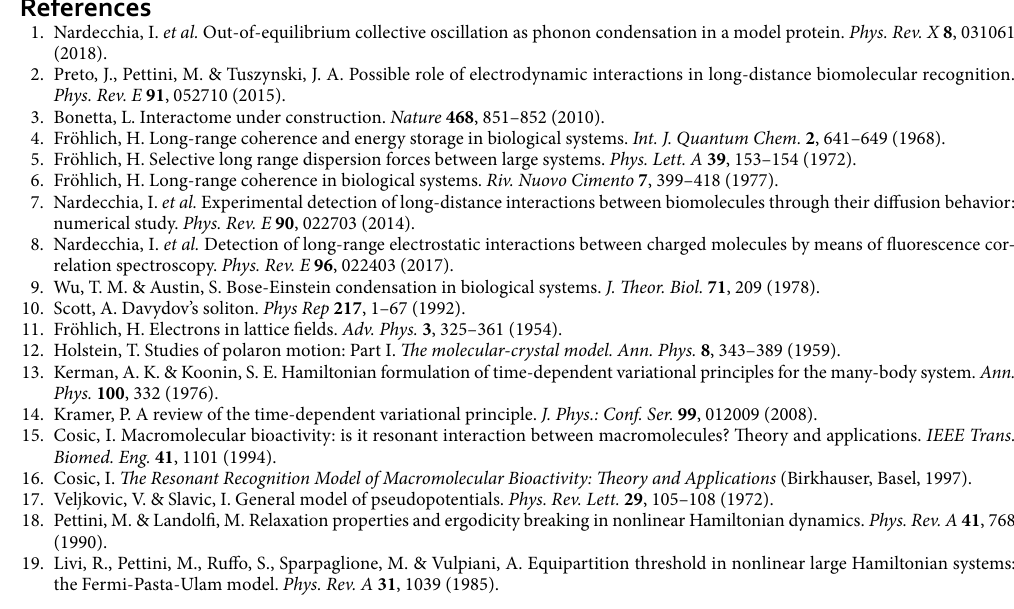
0.5 ( χ 61 = = 0.5 (light green). Upper right panel: ′ = 0.3 (red), µ 0.5 (light green). Lower ′ = ′ = 1. (blue), ǫ 5. (red), ǫ 10. (light ′ = ′ = ′ =